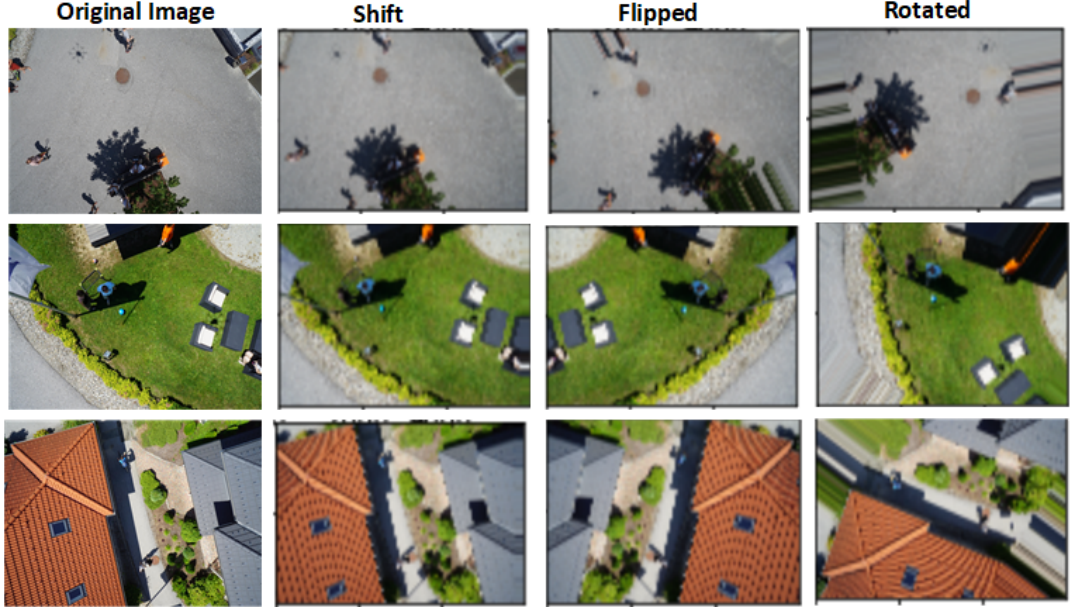
Figure 3. Results of data augmentation performed to increase variation in the data